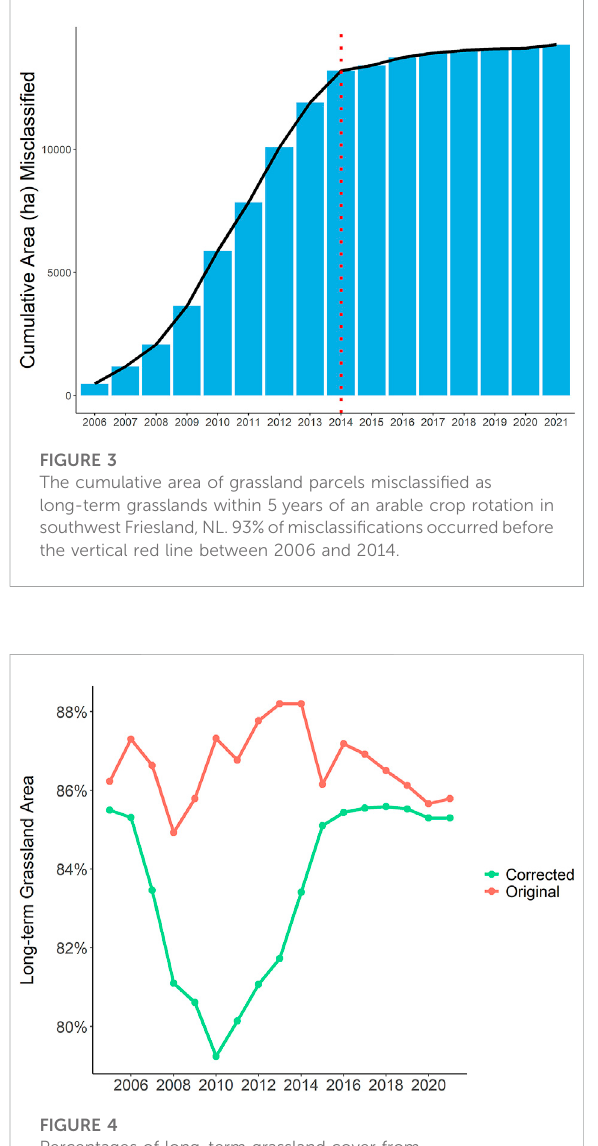
FIGURE 4 Percentages of long-term grassland cover from 2005 – 2021 in southwest Friesland, NL calculated from original BRP data (red line) and corrected BRP data (green line). See Supplementary Table S5 in Supplementary Table for annual change in long-term grassland